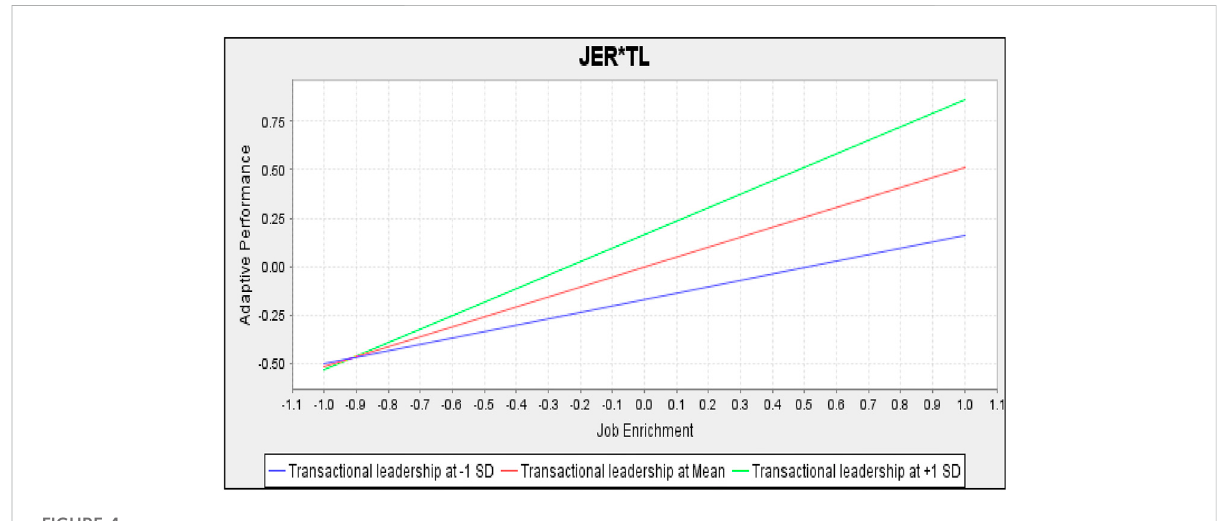
FIGURE 4 Moderation